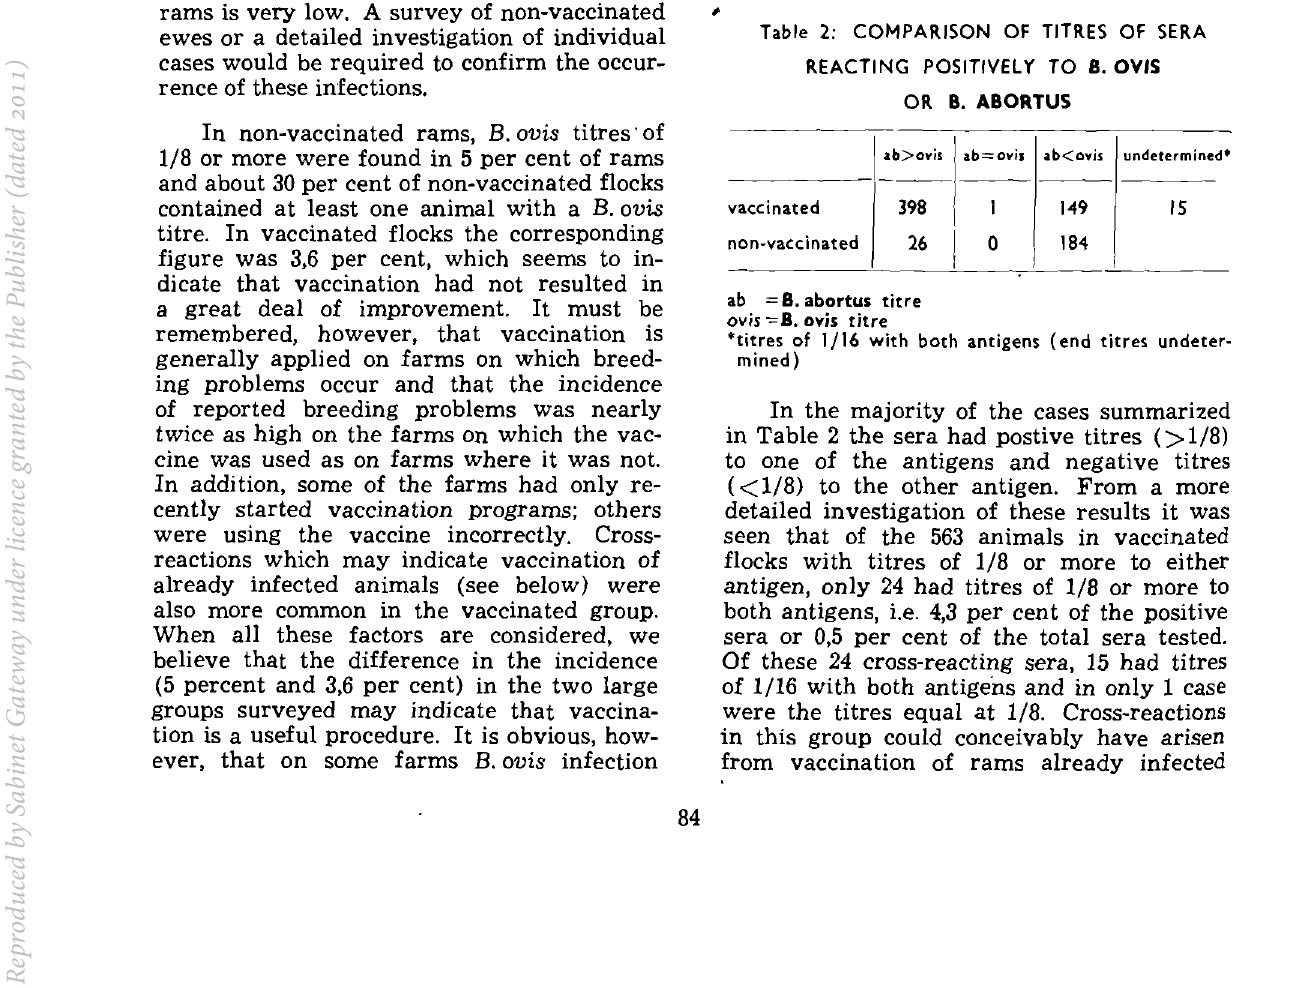
Table 2: COMPARISON OF TlTRES OF